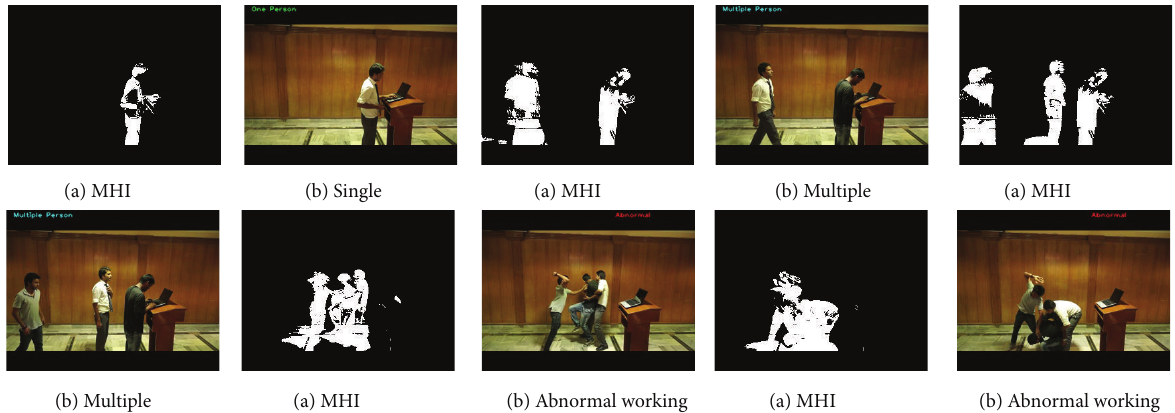
Figure 5: MHI of 5 frames (black and white (a)) and prediction by LibSVM (colored (b)) for each class (left to right).